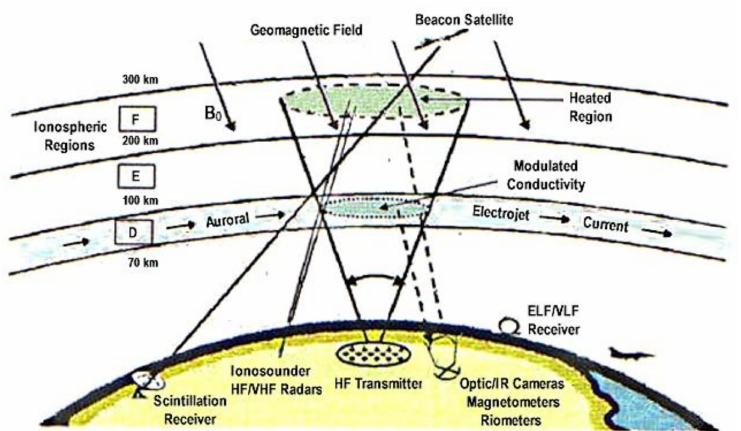
Figure 1. Ionospheric heating experiments and some remote-sensing